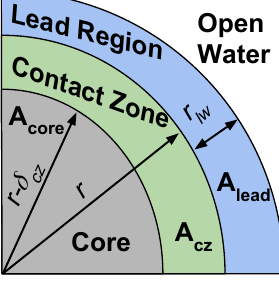
Figure 1. A section of a floe, showing the division of a floe and the surrounding sea surface for the thermodynamic and mechanical interaction components of the FSTD model. The floe itself, of radius r , is divided into the core which is unaffected by ridging and rafting (blue, width r − δ cz ) and contact zone which participates in these interactions (green, width δ cz ). The floe is surrounded by the lead region of width r lw where net heat fluxes lead to freezing or melting of the floe itself (blue) and then by open water where cooling may lead to new pancake ice formation